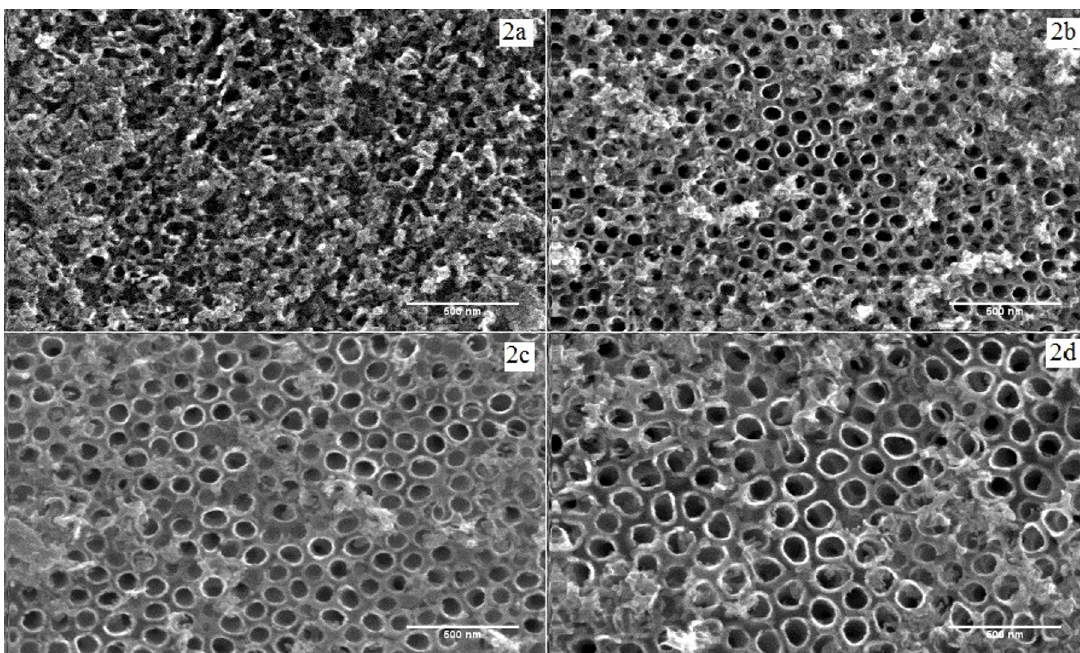
Figure 2. SEM micrographs of the Ti-7.5Mo alloy after anodization at 20V and 30V for 24 hours and 48 hours, calcined at 600 ºC: samples anodized at 20 V (2a and 2c) and 30 V (2b and 2d)